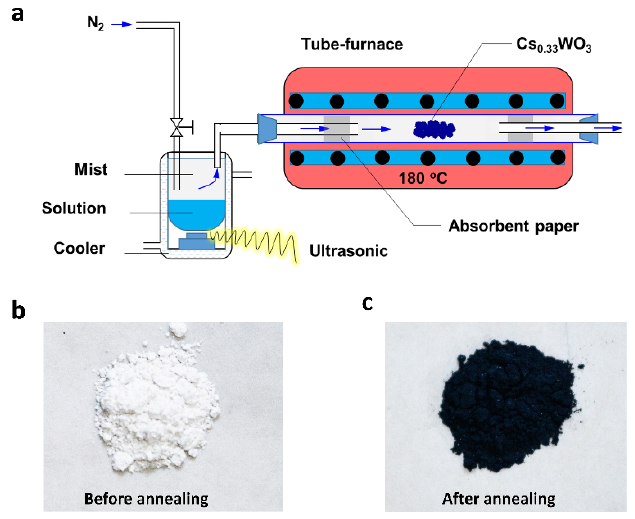
Figure 1. Preparation of Cs 0.33 WO nanoparticles (NPs): ( a ) schematic illustration of a mist chemical vapor deposition (mist-CVD apparatus), and photographs of Cs 0.33 WO NPs ( b ) before and ( c ) after annealing in reducing atmosphere at 550 °C.